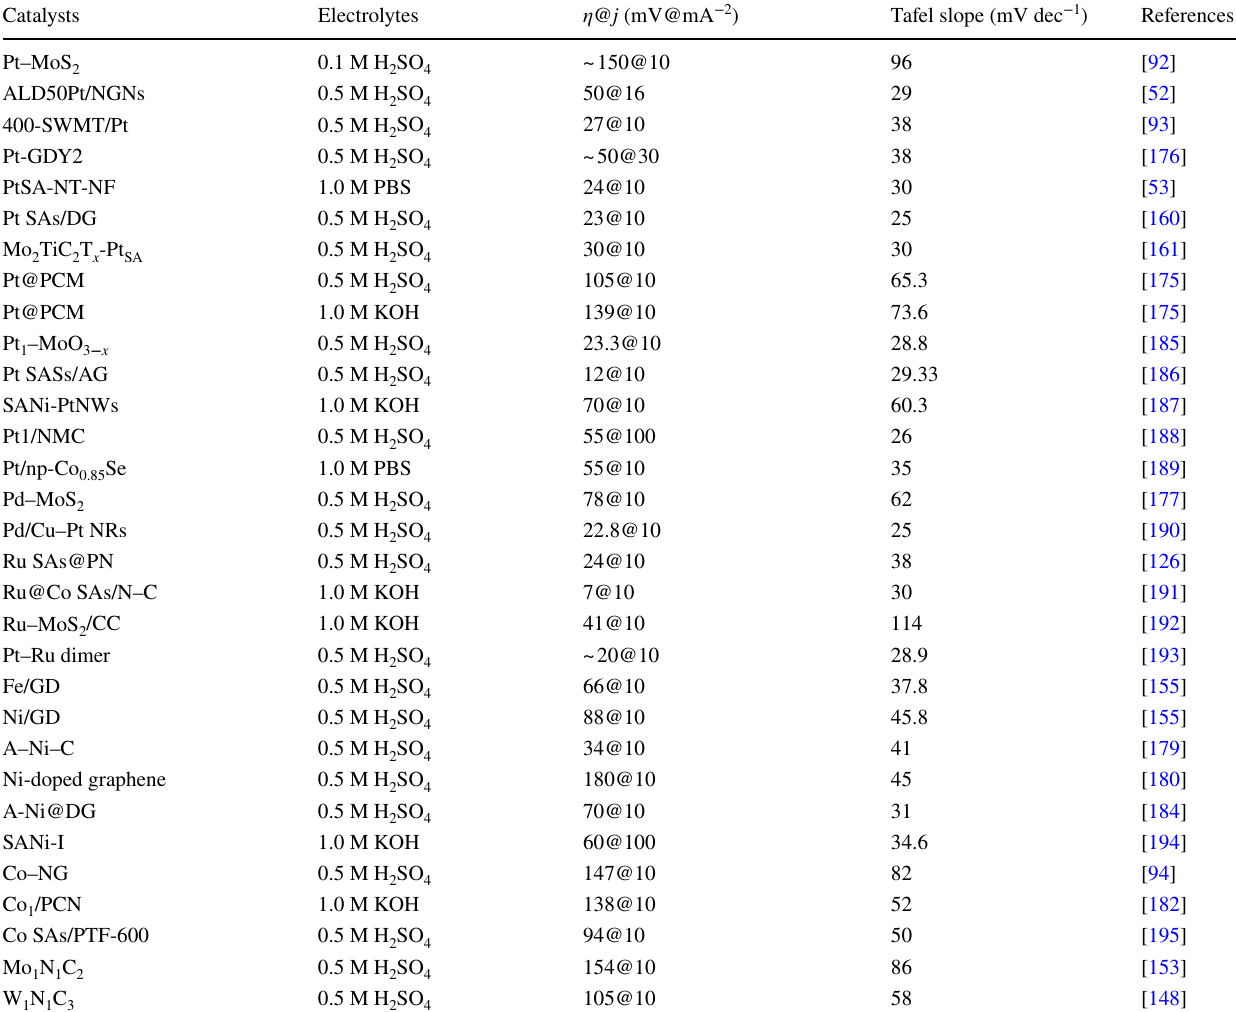
Table 2 Summary of the HER activity of SACs in acid/neutral/alkaline solutions